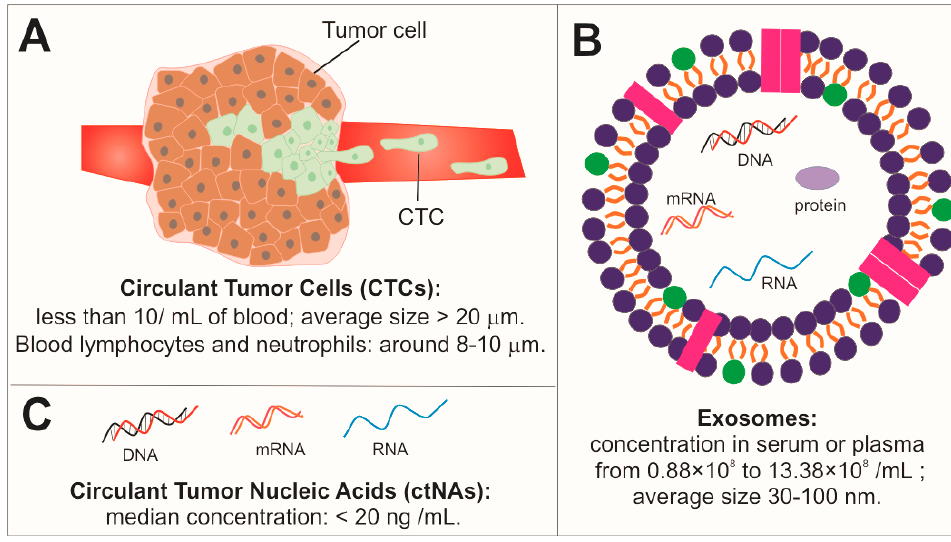
Figure 1. Schematic representation of typical cancer biomarkers of liquid biopsy: ( A ) Circulating tumor cells (CTCs); ( B ) Exosomes (EXs); ( C ) Circulant nucleic acids (ctNAs).